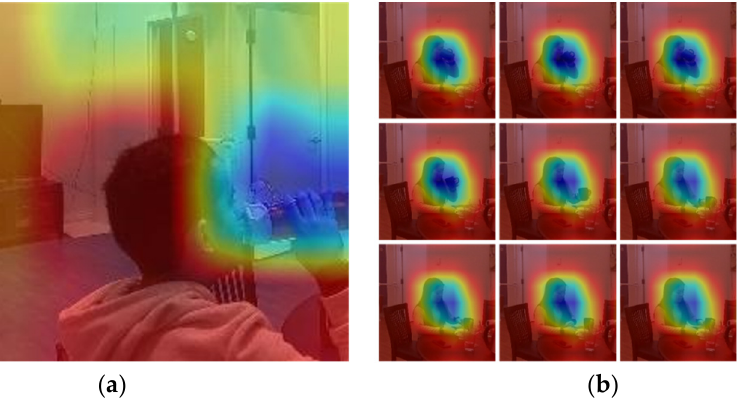
Figure 8. Gradient class activation maps for ( a ) 2D example and ( b ) the frames of a 3D example.